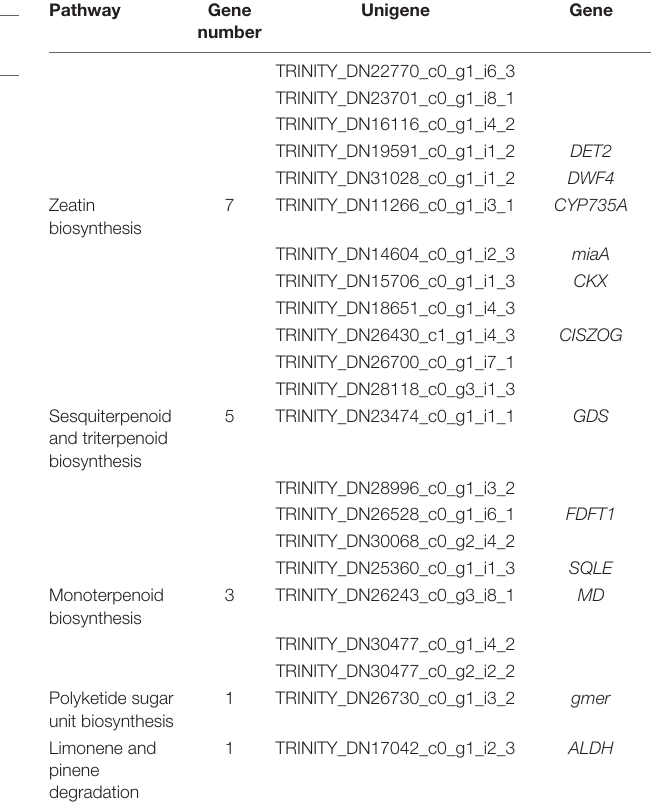
TABLE 1 | MicroRNAs target functions involved in the metabolism of terpenoids and